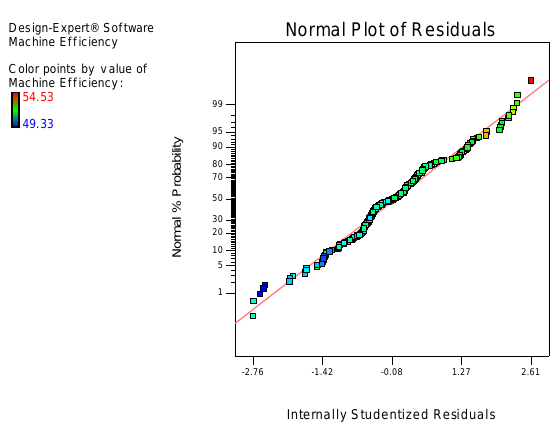
Figure 16. Normal plot of residuals for the ANOVA test on machine efficiency